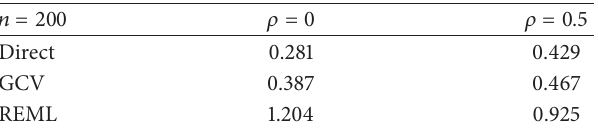
10 2 times their actual values.